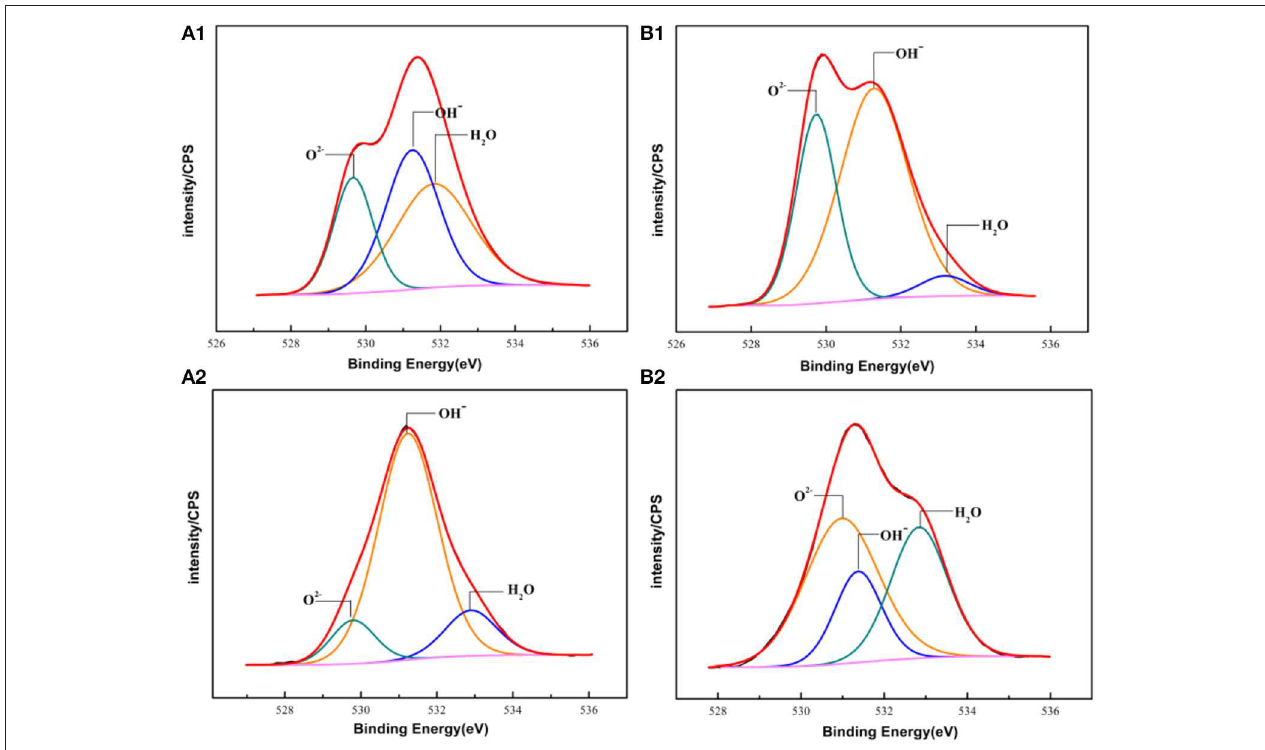
FIGURE 10 | The XPS spectra of O 1s of the passive films formed on PH13-8Mo stainless steel surface (A1,B1) Bare and pre-passivated sample before exposure; (A2,B2) Bare and pre-passivated sample after 5 year exposure.